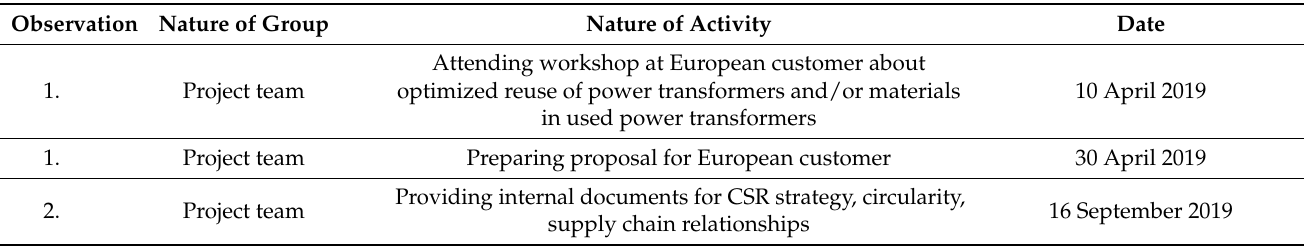
Table 3. Overview of three participative